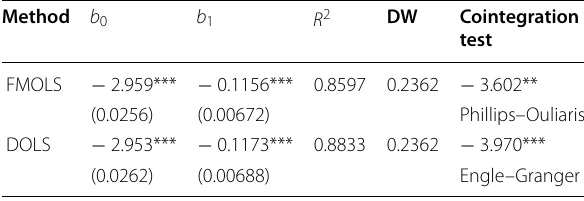
Newey–West standard errors in parentheses *, **, ***indicates significance at the 10, 5 and 1% level,